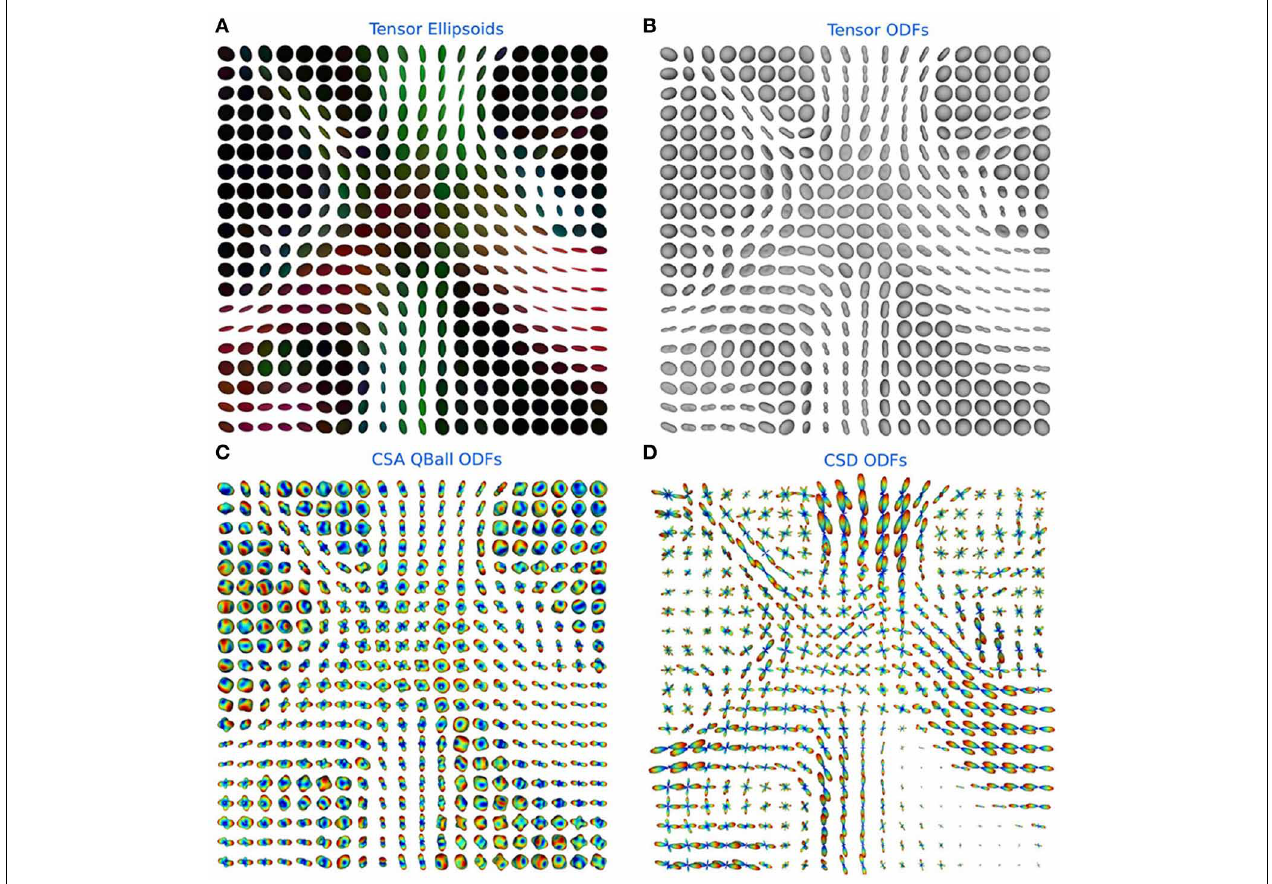
FIGURE 6 | (A) Tensor ellipsoids color-coded with a DEC map, (B) tensor ODFs, (C) constant solid angle ODFs, and (D) constrained spherical deconvolution ODFs in a region in the centrum semiovale showing crossings between the corpus callosum, corticospinal tract and the superior longitudinal